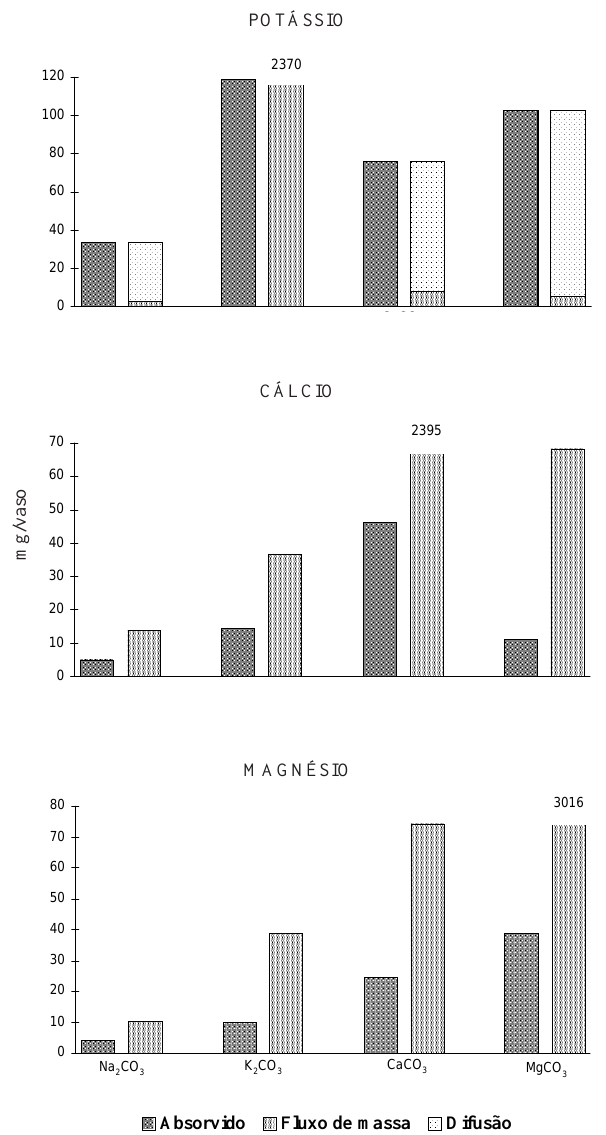
Figura 1. Quantidade de potássio, de cálcio e de magnésio em plantas de arroz e estimativa das quantidades do elemento transportadas por fluxo de massa e por difusão, considerando o sal adicionado ao